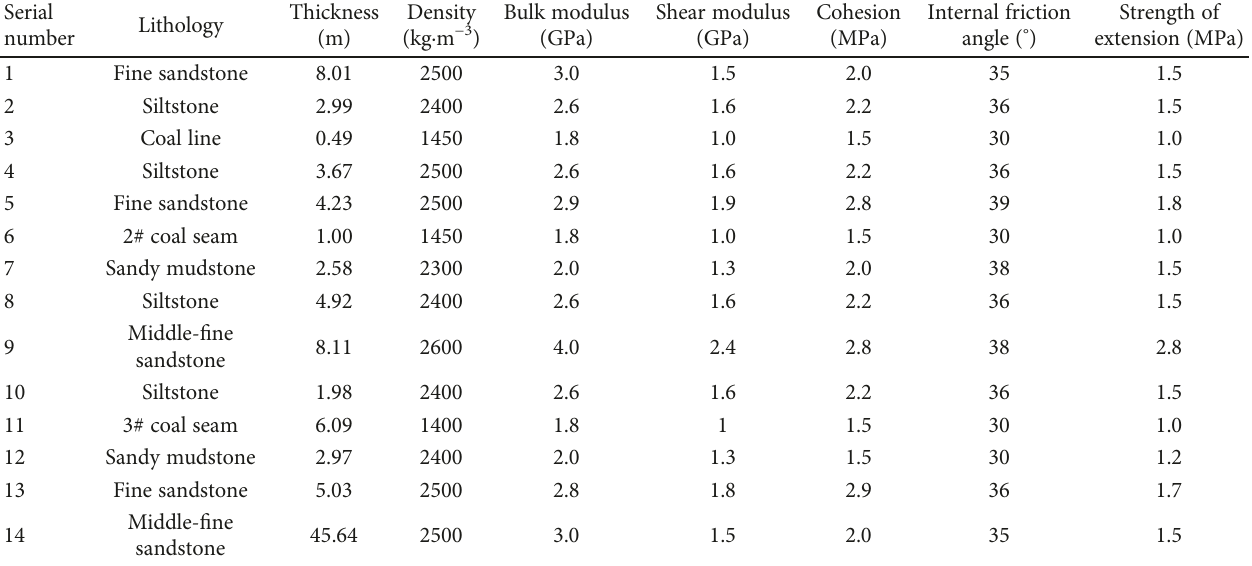
Table 1: Physical and mechanical parameters of the rock and